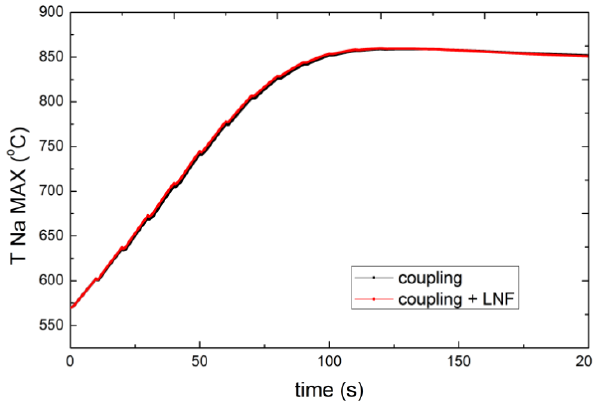
Fig. 19. Sodium maximal temperature during ULOF/PP accident with coupling and different Doppler